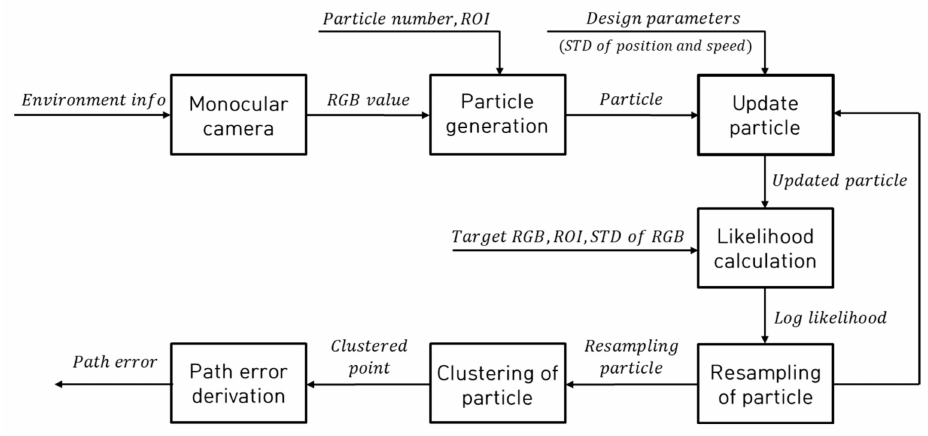
Figure 2. Block diagram for the particle-filter-based path tracking error